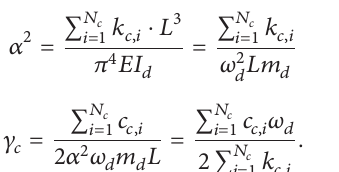
reactions. The impulse response in terms of the transverse bending moments, not reported here due to space con- straints, is also influenced by the higher modes contribution, but at a less extent than the abutment